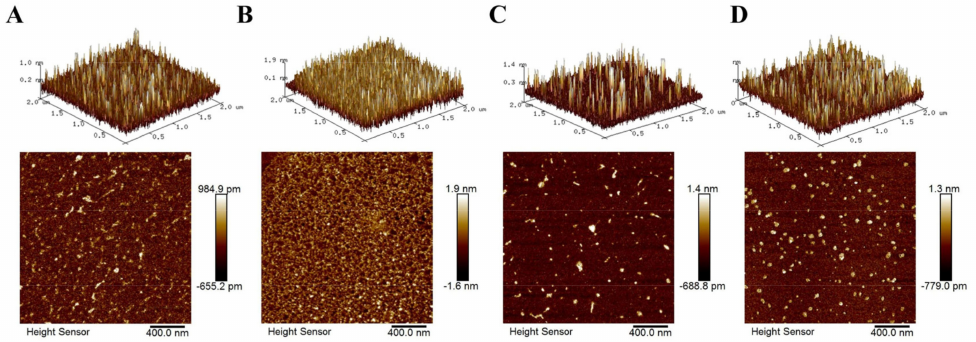
Figure 5. Atomic force microscope topography of anthocyanin compound − binary complex. ( A ) p3cr5g; ( B ) p3cr5g − PX; ( C ) p3cr5g − ECT; ( D ) p3cr5g − DG; three − dimensional images (upper)